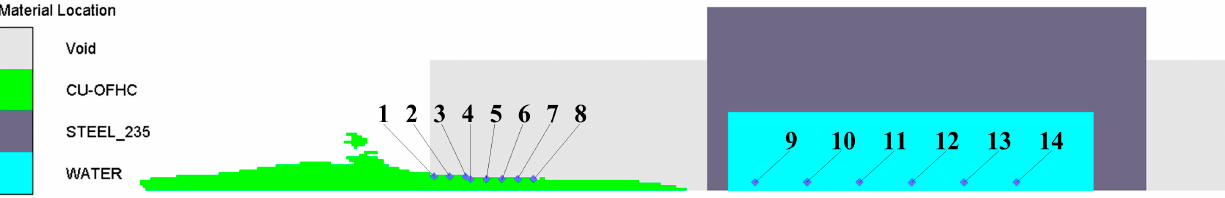
Figure 7. Jet velocity distribution at 24 µs.